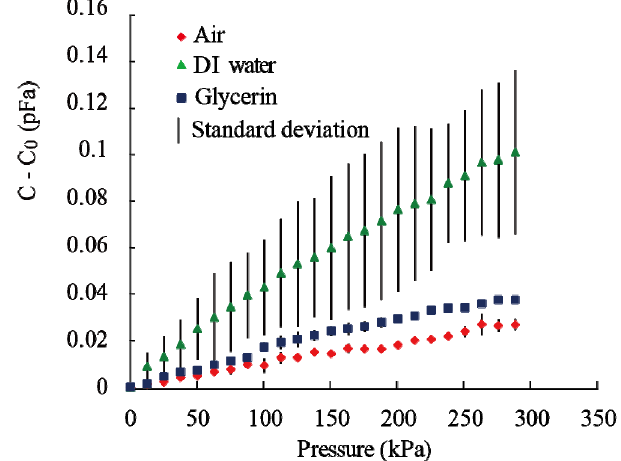
Figure 8. Increase of the capacitance with respect to the applied pressure. The encapsulated liquid successfully enhanced the sensor